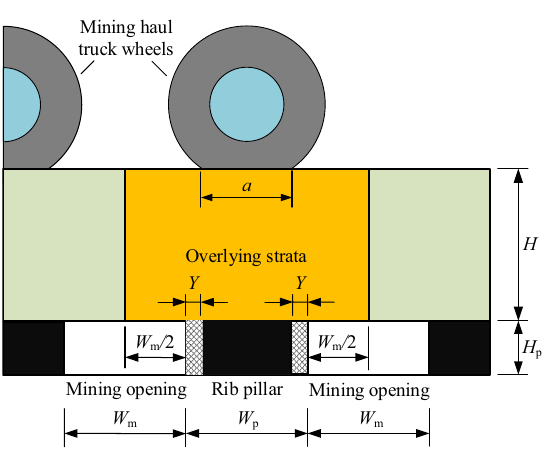
Fig. 1 Load-bearing of the rib pillar in highwall mining